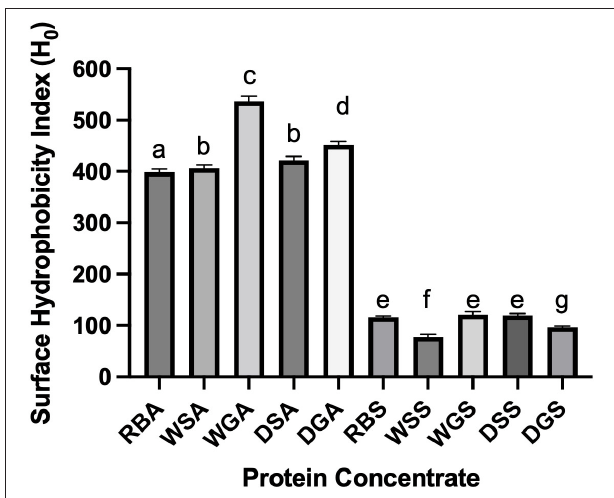
FIGURE 2 | Surface hydrophobicity index (H 0 ) of alkaline- and salt-extracted Yellow Eye bean protein concentrates ( n = 3). Different letters (a to g) represent significant differences by Tukey’s multiple comparison test ( p <